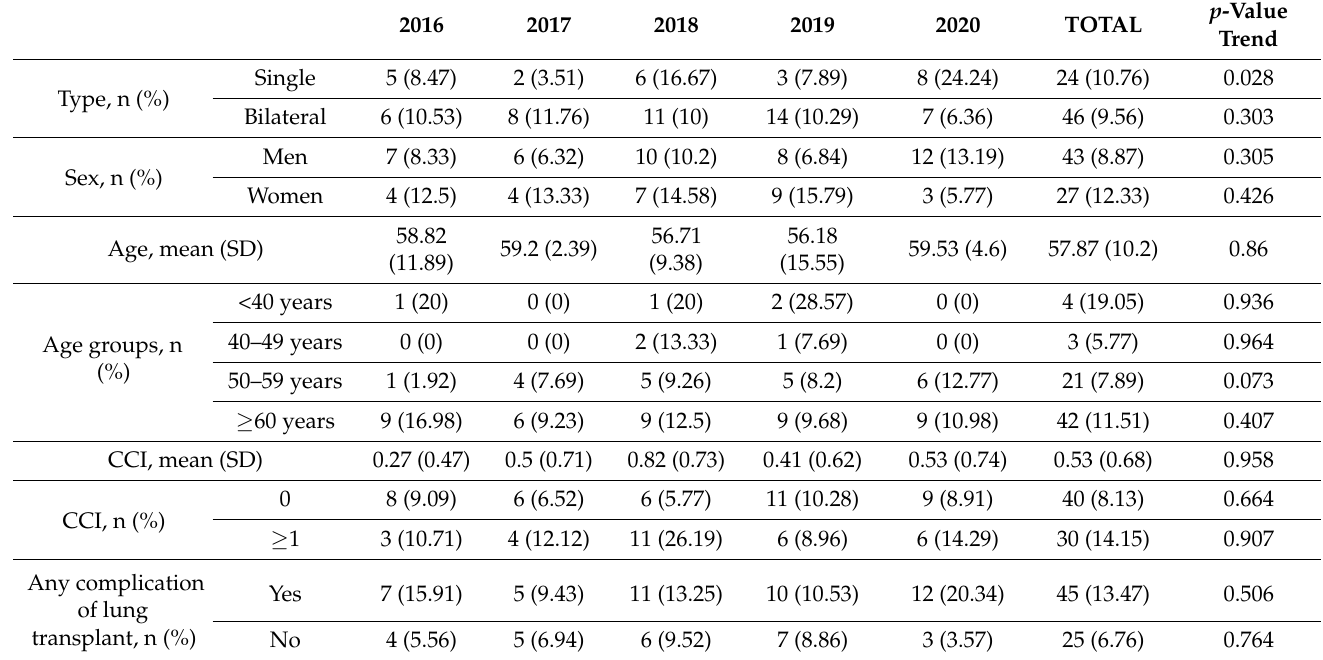
Table 4. In hospital mortality according to study variables among patients with COPD who under- went a lung transplantation in Spain from 2016 to